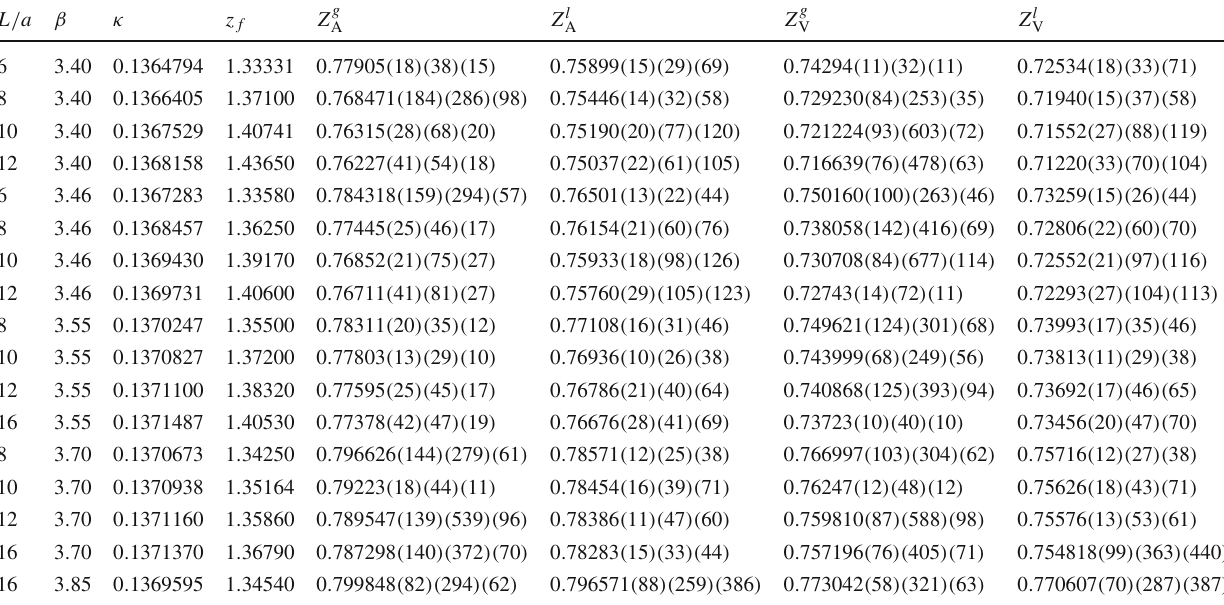
, l for the different N f = 3 )latticeartefactssubtractedareobtainedfromthose resultswiththeO( g 2 A , V 0 below by applying Eq. (3.6) to the mean values and corresponding sta- Z A , V ) , and system- tistical errors. The systematic uncertainties are instead left unchanged 0 ((cid:14) ) . The corresponding (cf. Table z f Z A , V f